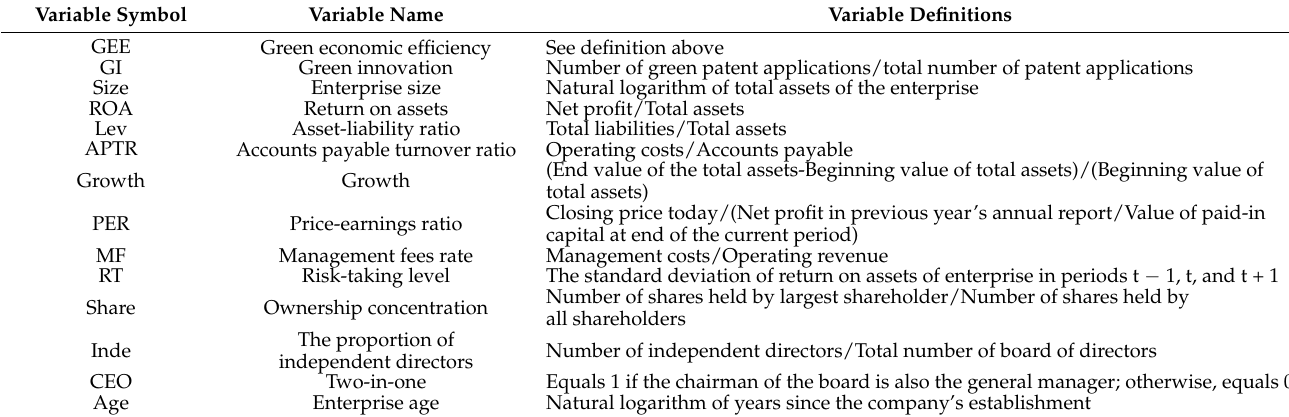
Table A1. Variable definitions.